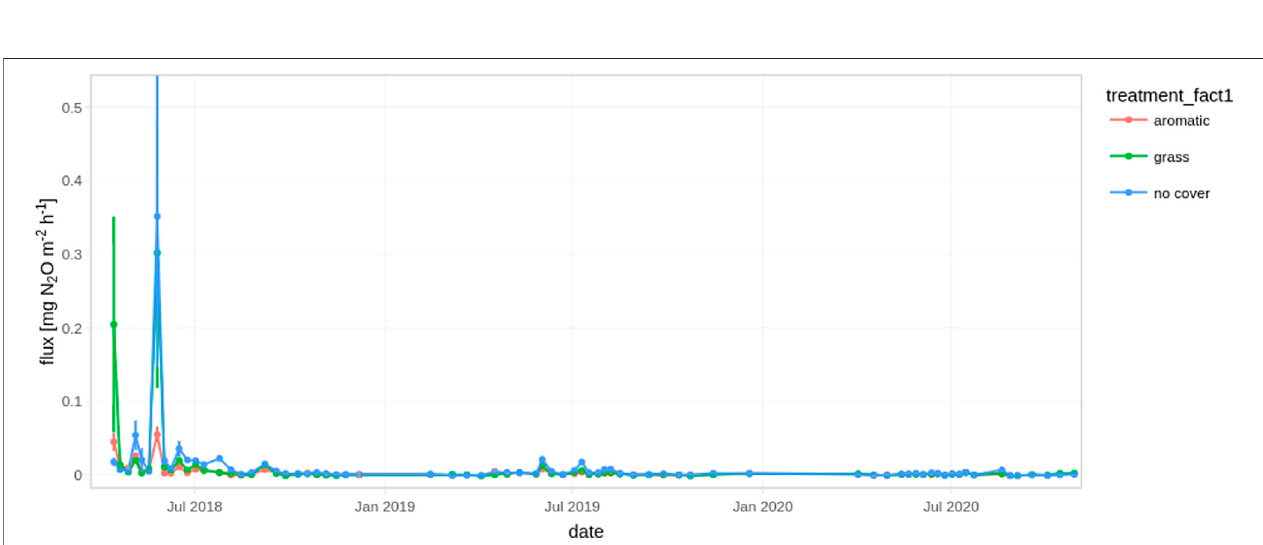
FIGURE 9 | N 2 O emissions of CS11 during the three growing seasons (2018 – 2020) averaged by the diversi fi cation treatment (aromatic herbs, grass and no cover as control) with error bars indicating 1 standard error.